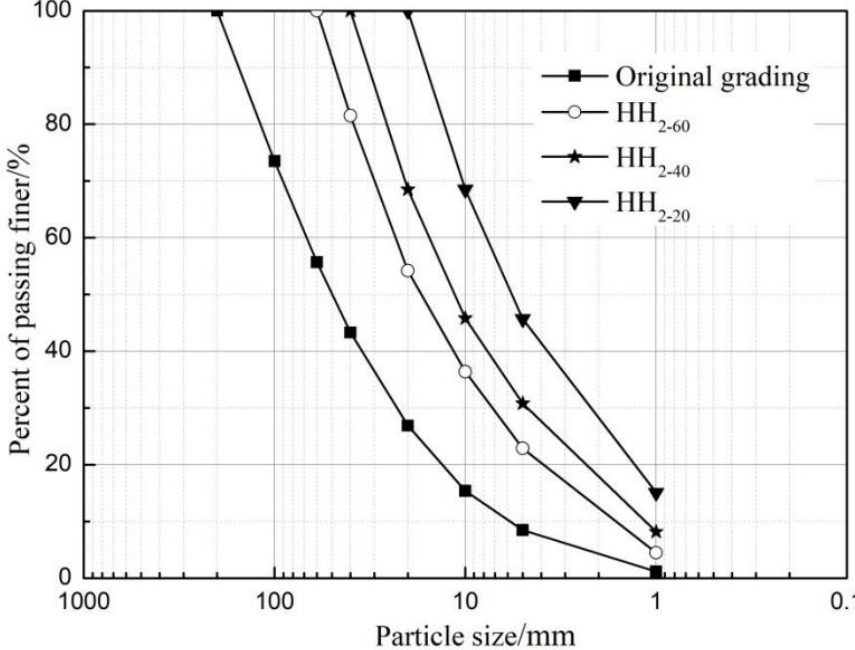
Figure 2. Grain-size distribution curves of rockfill materials. Table 1. The test gradation of rockfill materials and tested results.